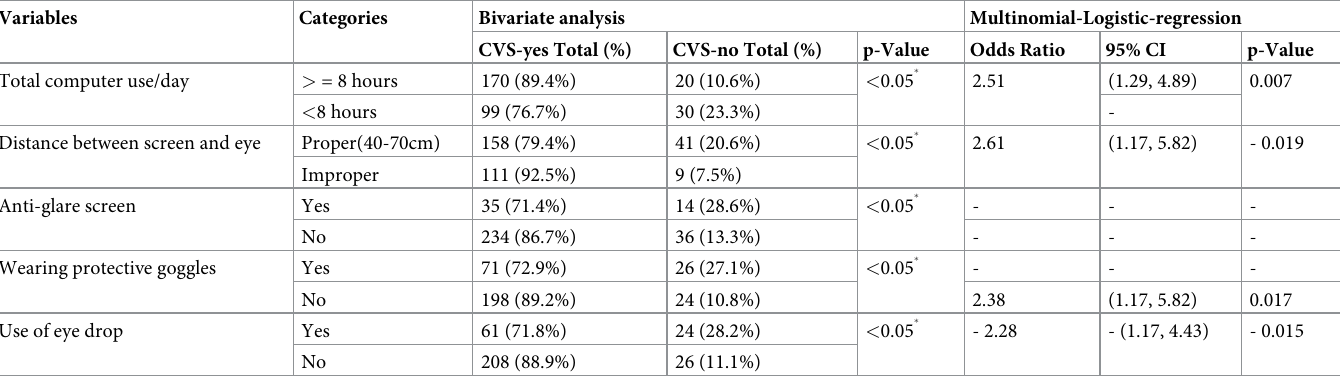
Table 4. Association between CVS and study